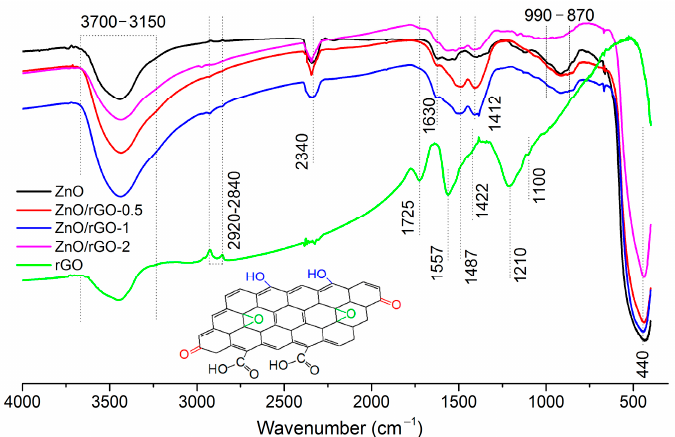
Figure 4. FTIR spectra of rGO, ZnO nanofibers, and ZnO/rGO nanocomposites. The X-ray photoelectron spectra confirm the presence of various oxygen-containing groups on the rGO surface. Figure 5a shows the C1s region of the rGO XP- spectrum, containing components with binding energies of 284.51, 285.68, 288.6, and 291.38 eV corresponding to carbon in sp 2 -hybridized C–C bonds, alkoxyl C–O, carbonyl C=O, and carboxyl COOH groups, respectively. The O1s region of the rGO spectrum (Figure 5d) contains two components with binding energies of 531.56 and 533.16 eV, which can be attributed to oxygen in the alkoxyl C–O and carbonyl C=O groups, and oxygen in the hydroxyl OH and carboxyl COOH groups, respectively. The fraction of hydroxyl OH and The spectra of ZnO nanofibers (Figure 5b) and the ZnO/rGO-1 composite (Figure 5c) in (ZnO) and 284.88, 268.44, 289.14 eV (ZnO/rGO-1), which can be attributed to